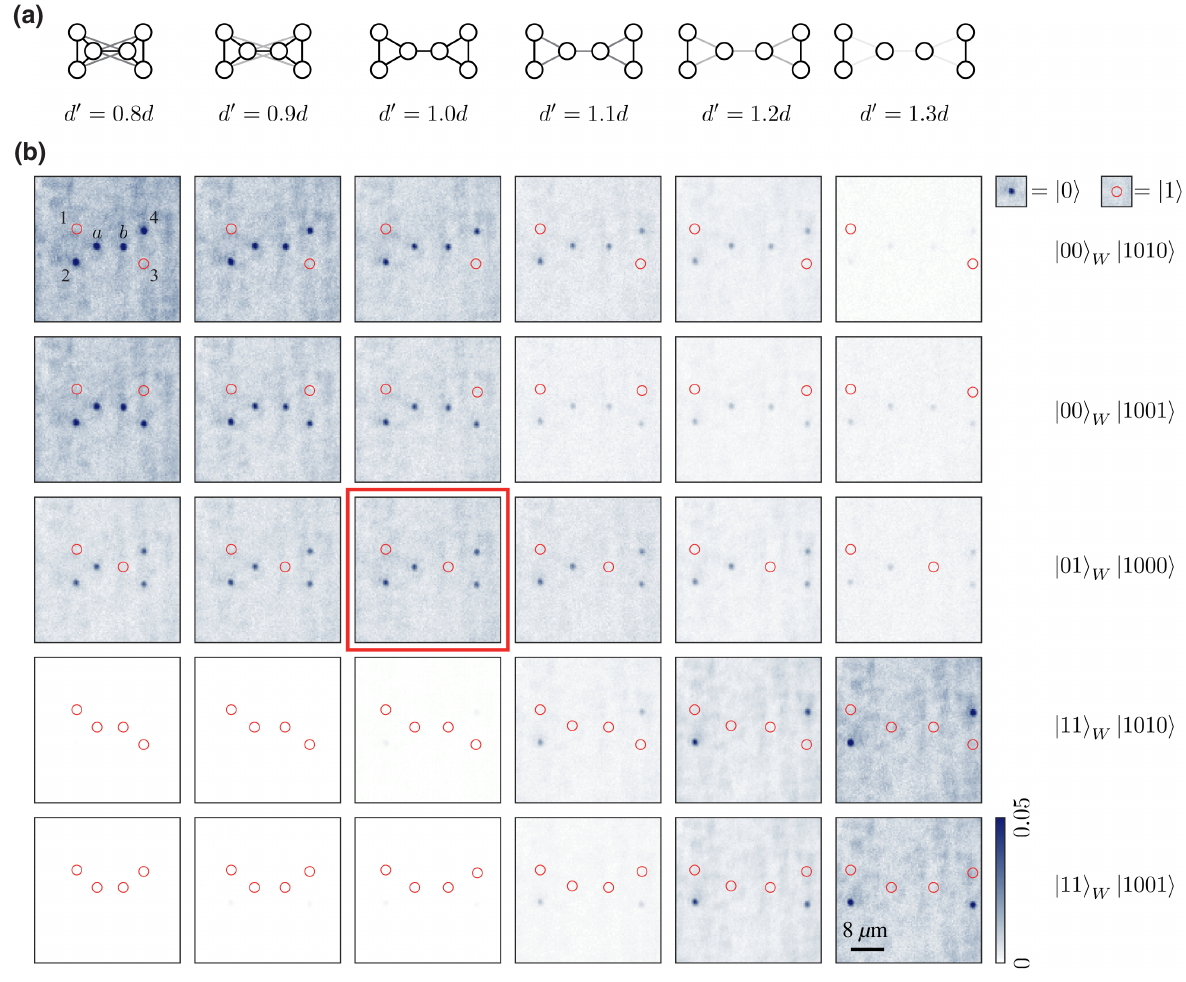
FIG. 3. The K (cid:6) -like graphs of two types of edges. (a) Six different graphs are constructed with d (cid:6) / d = 0.8, 0.9, 1.0, 1.1, 1.2, and 1.3 4 . (b) Fluorescence images of the atom arrays driven (from left to right), among which the d (cid:6) = d = 0.76 d R graph corresponds to K (cid:6) 4 to H ((cid:2) f = 0, (cid:4) f = 2.0 MHz, U = 3.9 MHz ) and sorted based on their spin configurations. Five characteristic spin configurations are shown (from top to bottom): | 00 (cid:4) W | 1010 (cid:4) , | 00 (cid:4) W | 1001 (cid:4) , | 01 (cid:4) W | 1000 (cid:4) , | 11 (cid:4) W | 1010 (cid:4) , and | 11 (cid:4) W | 1001 (cid:4) . The scale bar represents the relative probabilities of the configurations per graph. The numbers of collected events are 1057, 971, 927, 906, 2866, and 918 (from left to right), respectively, for the